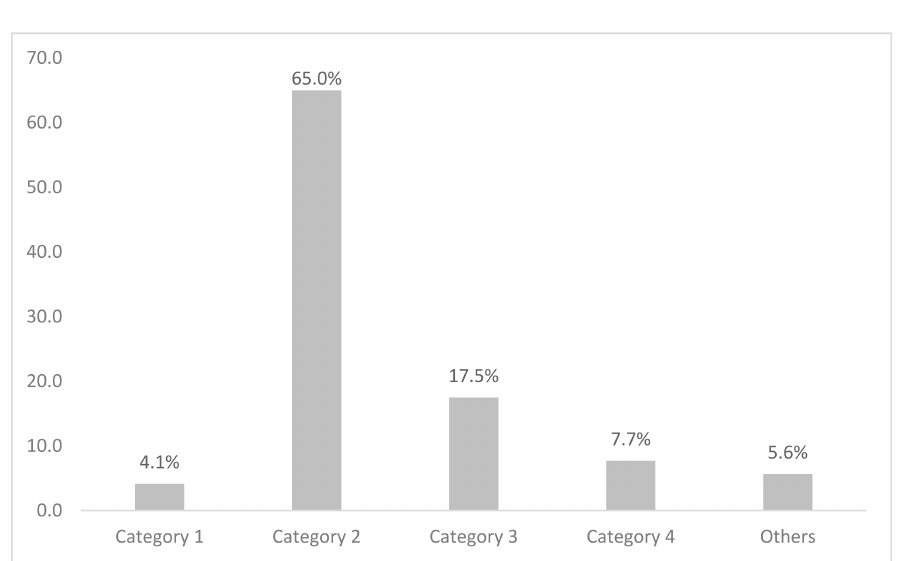
Figure 1. Preference of alcoholic beverages among current drinkers in Malaysia.